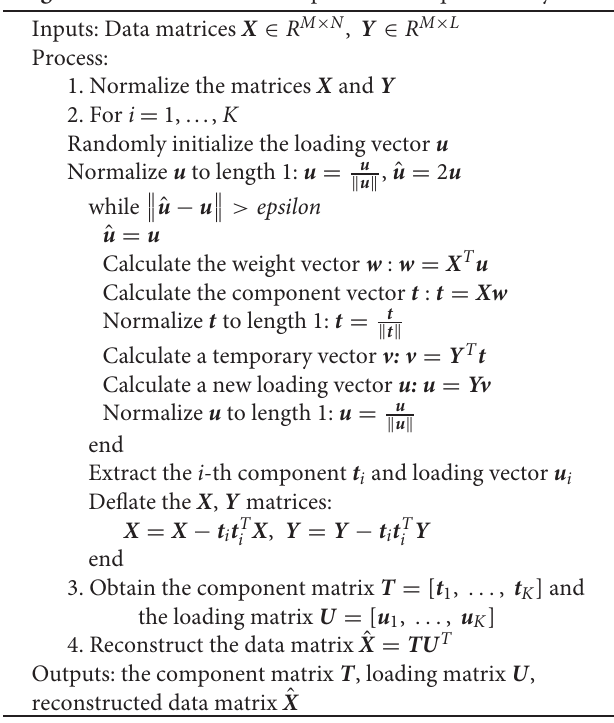
Algorithm 1: Pseudo-code for partial least squares